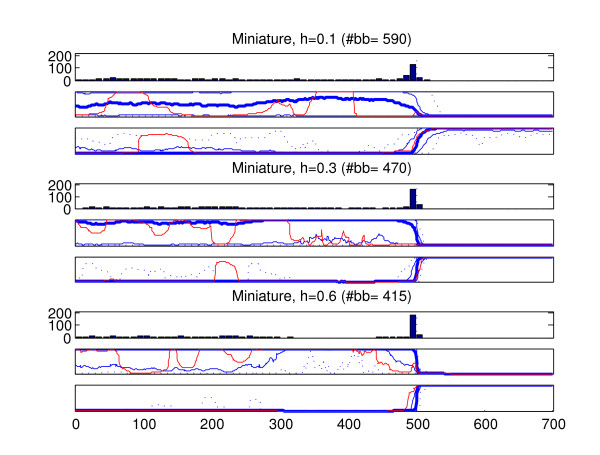
Results, recombination event involving a miniature cluster. Summary of results for 200 strains belonging to a miniature population with a recombined fragment from another population. Sites 501–700 have been obtained through recombination. See Figure 6 for the interpretation of the figure. As in Figure 8, the situation between the right- and left-side origins is asymmetric. Therefore, we show also a summary plot of the probabilities for the right-side origin in the marginal probability profiles (the third plot for each tree height). As in Figure 6, the 'correct' marginal probability profile would assign probability unity for the left-side origin in sites 1–500 and probability zero in sites 501–700. The 'correct' probabilities for the right-side origin would be zero in sites 1–500 and unity in sites 501–700.